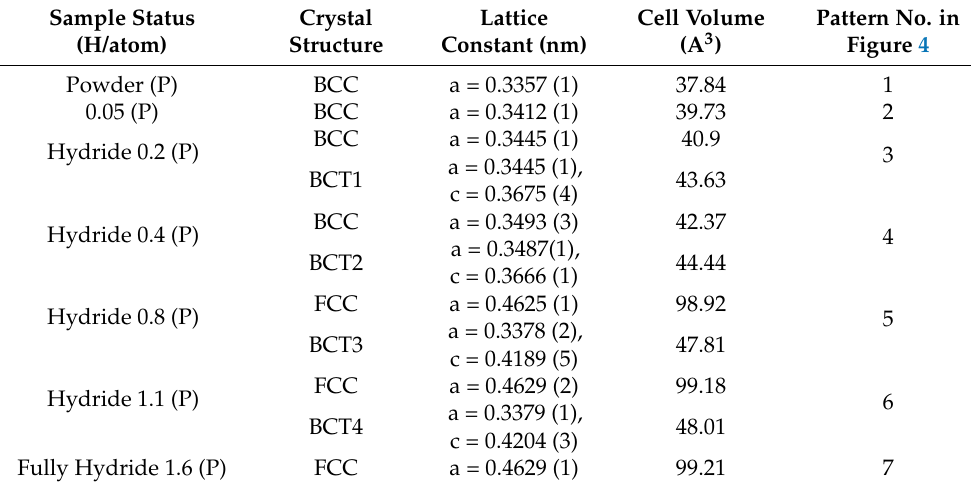
Figure 4. The XRD patterns of Ti 0.20 Zr 0.20 Hf 0.20 Nb 0.40 alloy charged with differing hydrogen content: (1) Powder (P), (2) 0.05 H/atom (P), (3) 0.2 H/atom (P), (4) 0.4 H/atom (P), (5) 0.8 H/atom (P), (6) 1.1 H/atom (P), (7) 1.6 H/atom (fully hydride). Table 2. The crystal structure, lattice constant and volume of the synthesized Ti 0.20 Zr 0.20 Hf 0.20 Nb 0.40 HEA with differing hydrogen content. BCC, body-centered cubic (BCC); BCT body-centered tetragonal (BCT); FCC, face-centered cubic.